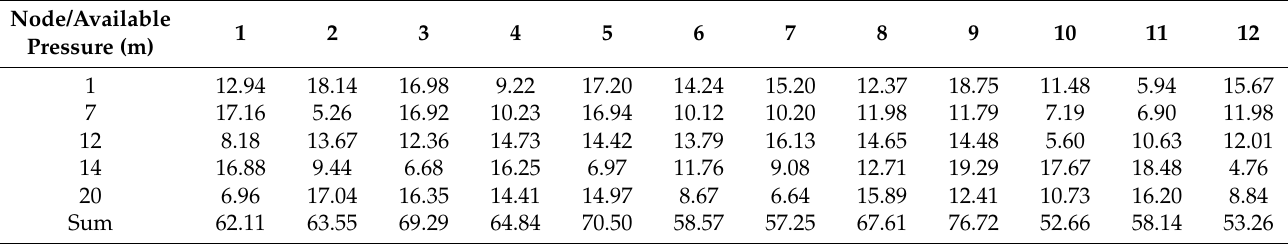
Table 4. Excessive pressure at the first 12 h.